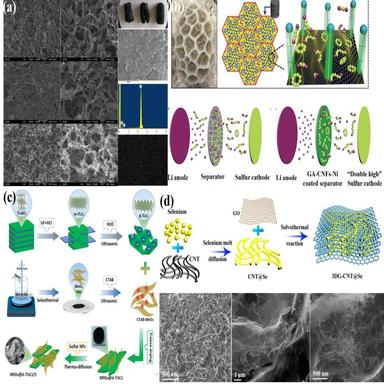
(a) Low and high magnification SEM images of GA-S-120, GA-S-150 andGA-S-180 hybrids, the digital images of as-prepared GA-S hybrids, and the EDS spectrum and element mapping of sulfur for GA-S hybrid Copyright 2015, Elsevier; (b) Schematic configuration of the synthesized GA-CNFs-Ni hybrids. Schematic diagram of the Li–S cells with: pristine separator; and GA-CNFs-Ni coated separator Copyright 2018, Royal Society of Chemistry; (c) Schematic illustration shows the synthesis proc